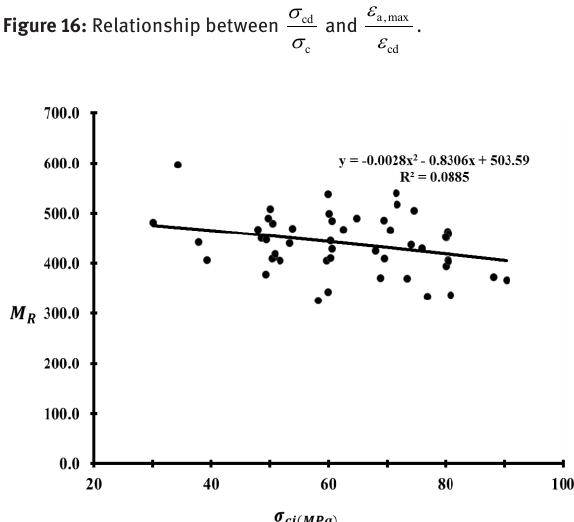
and crack 𝑀𝑀 𝑅𝑅